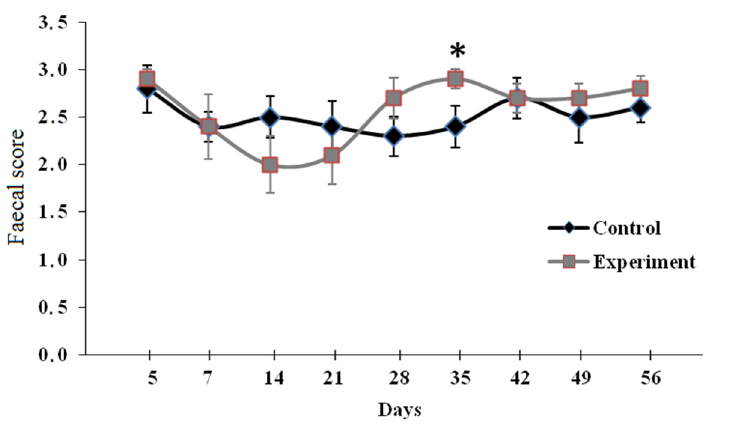
Figure 1. Mean (±standard error of the mean) faecal scores of control (CG, n = 10) and experimental (EG, n = 10) calves. CG, control group; EG, experimental group. * EG had a higher faecal score (p = 0.05) than CG on day